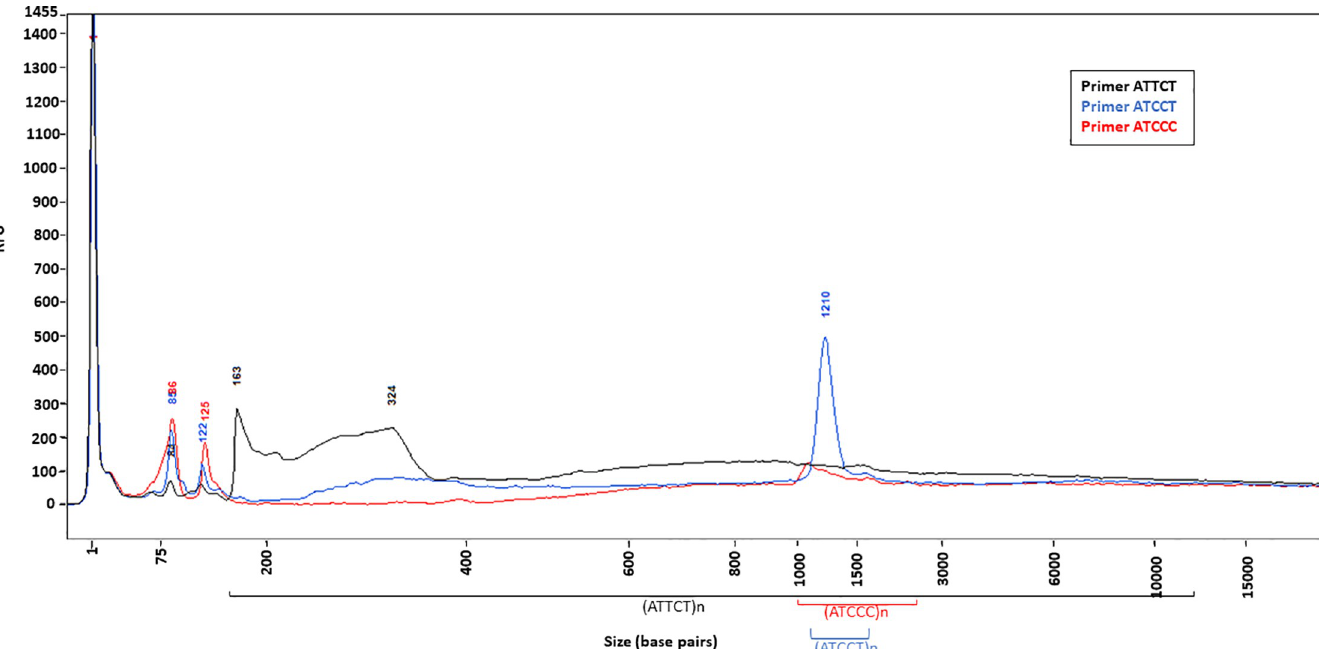
Fig 4. RP-FEMTO results of a SCA10 patient with an (ATTCT) n expansion maintaining an (ATCCT) n (ATCCC) n interruption. RP-FEMTO results of genomic DNA using ATTCT (black line), ATCCT (blue line) or ATCCC (red line) internal primer and running on the large separation gel. Some peaks overlap due to repeat length variation in the blood. Repeat starts at 163 bp. RP-FEMTO shows a genomic DNA population containing (ATTCT) 200 indicated by the black line, followed by (ATCCT)/(ATCCC) 500 indicated by the blue and red